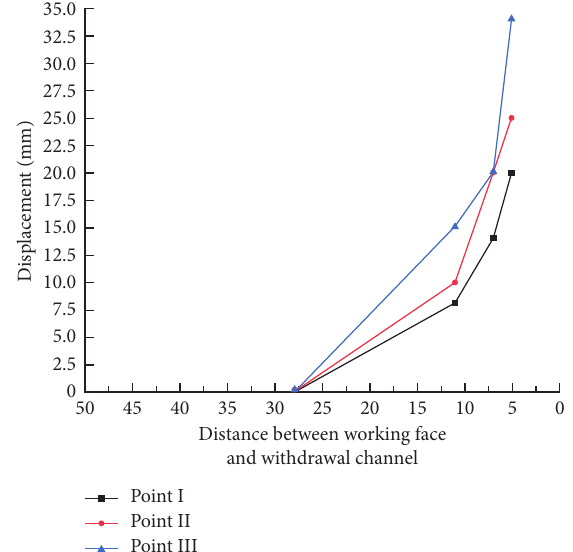
Figure 25: Displacement variations between ribs of auxiliary withdrawal